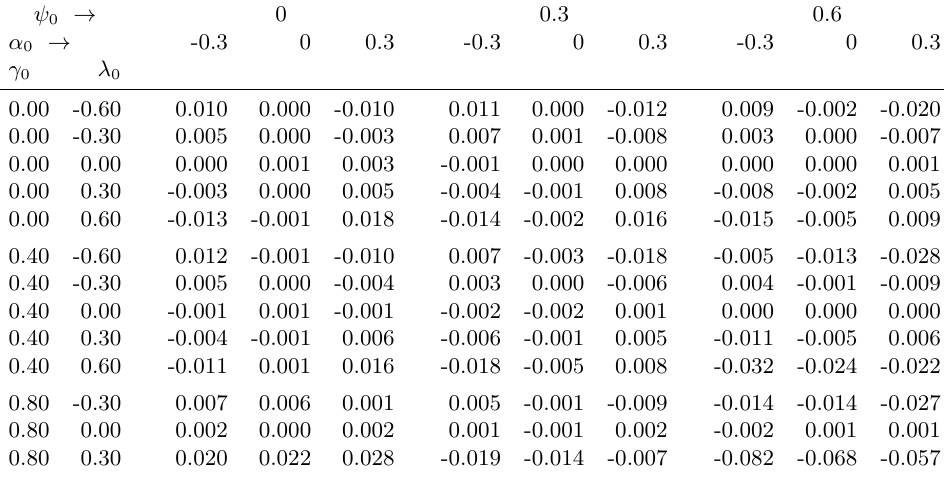
Table D.3: Bias of Team Dynamic – direct short-run marginal effect of